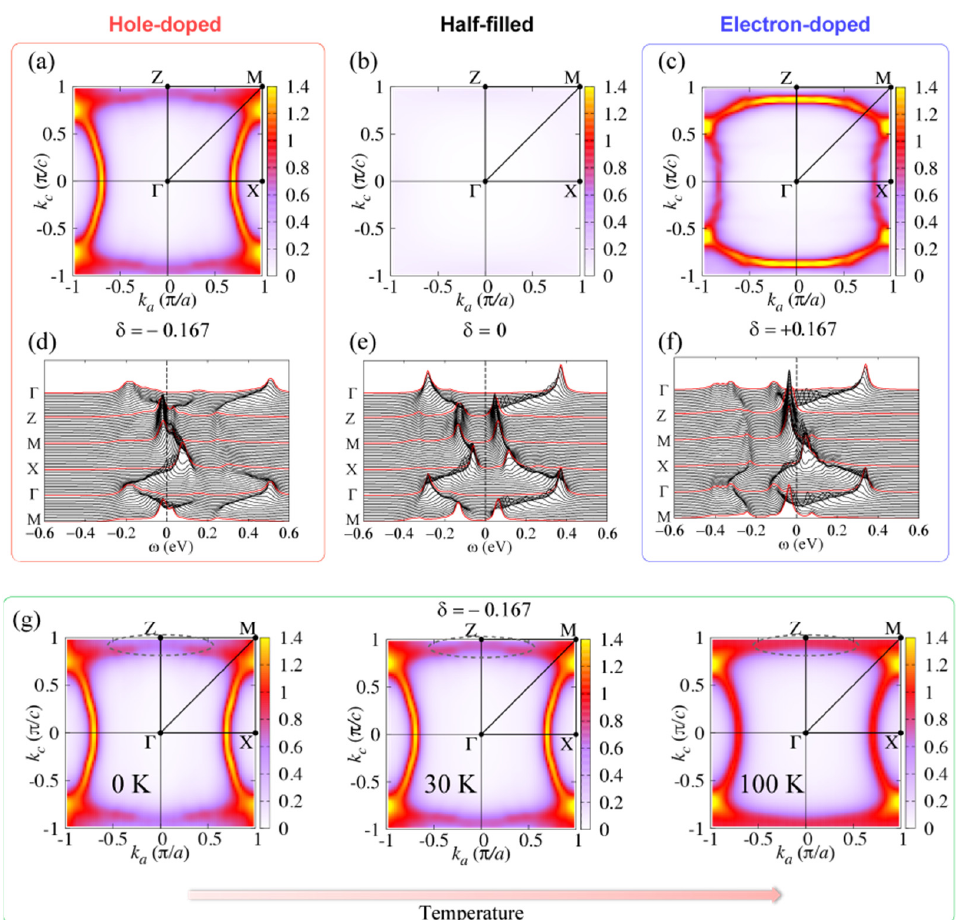
Figure 12. Fermi surfaces and single-particle spectral functions of the Hubbard model on an anisotropic triangular lattice at 30 K, calculated using the cluster perturbation theory (CPT). ( a – c ) Fermi surfaces for ( a ) 17% hole doping, ( b ) half filling, and ( c ) 17% electron doping, determined by the largest spectral intensity at the Fermi energy. ( d – f ) Single-particle spectral functions for (d) 17% hole doping, ( e ) half filling, and ( f ) 17% electron doping. The Fermi energy is located at 𝜔 = 0 and the parameter set of this model is 𝑡′/𝑡 = −0.44,𝑈/𝑡 = 5.5, and 𝑡 = 65 meV . ( g ) Temperature evolution of the spectral density at 17% hole doping. The suppression near the Z–M line diminishes at high temperatures.